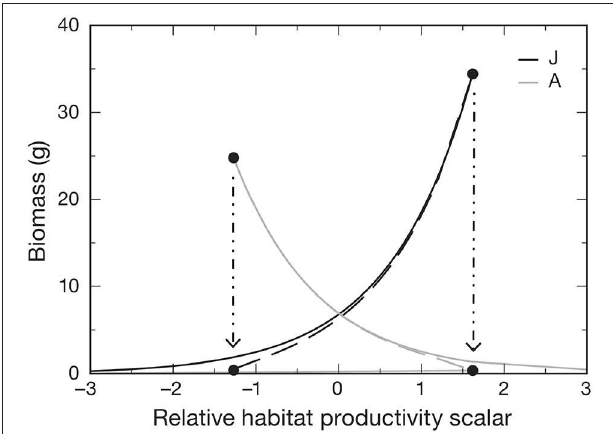
FIGURE 2 | Biomass of adult A and juvenile J life stages as a function of relative habitat productivity ( x ) showing where stages are under stable (solid lines) and unstable (dashed lines) equilibria. Alternative stable states occur between the hatched arrows, at which one of the alternative equilibria collapses and beyond which only one stable equilibrium occurs. Adult µ A and juvenile µ J mortality rates were both set to 0.05. Figure reproduced with permission (Inter-Research) from Van de Wolfshaar et al.